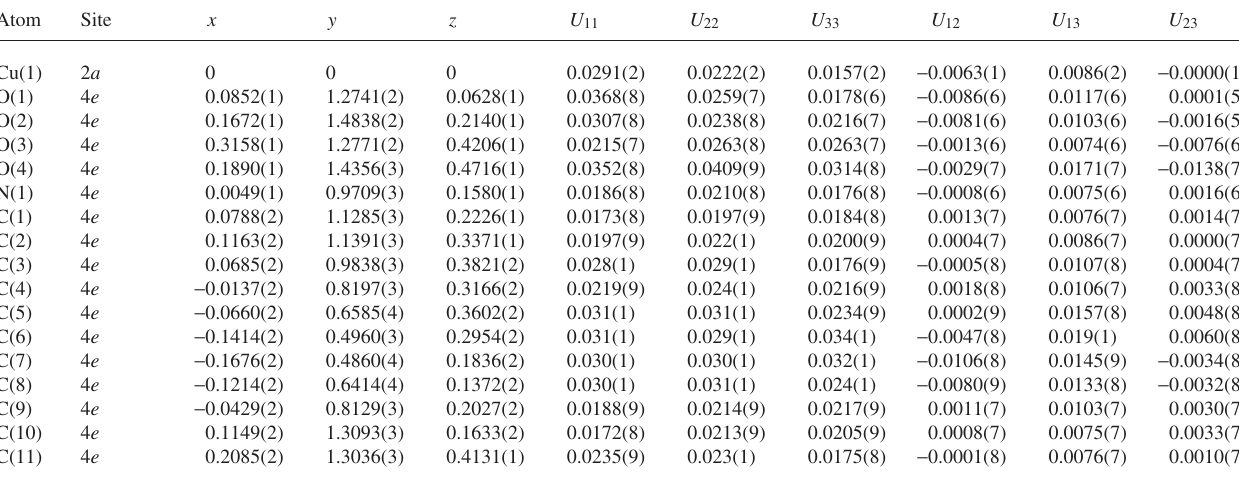
Table 3. Atomic coordinates and displacement parameters (in Å 2 )